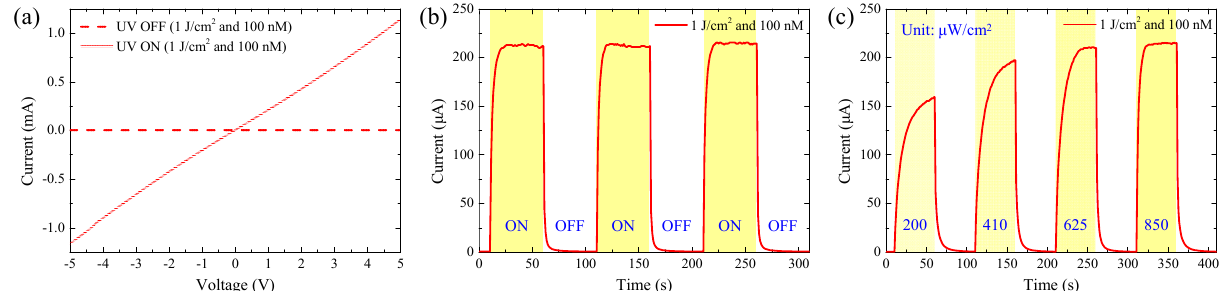
Figure 9. ( a ) I-V curves in absence and presence of UV, and temporal variations of ( b ) repeatability, and ( c ) UV light energy measurements of Ag-decorated the ZnO NWs.